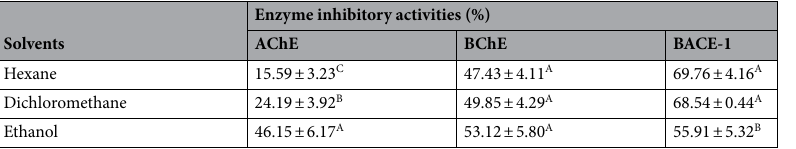
Table 2. Percentage enzyme inhibitory activities of D. esculentum extracted with hexane, dichloromethane and ethanol against AChE, BChE and BACE-1. Data are presented as mean ± SD of three independent experiments. Capital letters within a column for a given parameter are significantly different at p < 0.05. The final concentration of the extract was 1.25 mg/mL.